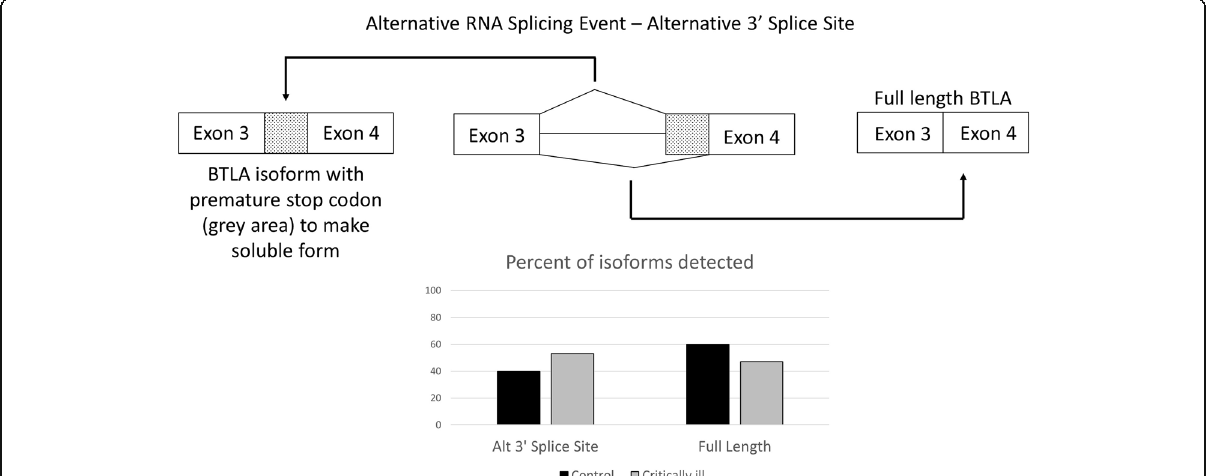
Fig. 3 – Alternative 3 ’ Splice Site of BTLA: The percentage of an alternative 3 ′ splice site at exon 4 is significantly different between critically ill mice (40%, n = 3) and healthy controls (53%, n = 3) (FDR =0.0000429857901449, bar graph to the left). The full length isoform is seen 60% of the time in the control mice and 47% of the time in the critically ill mice (bar graph to the right)